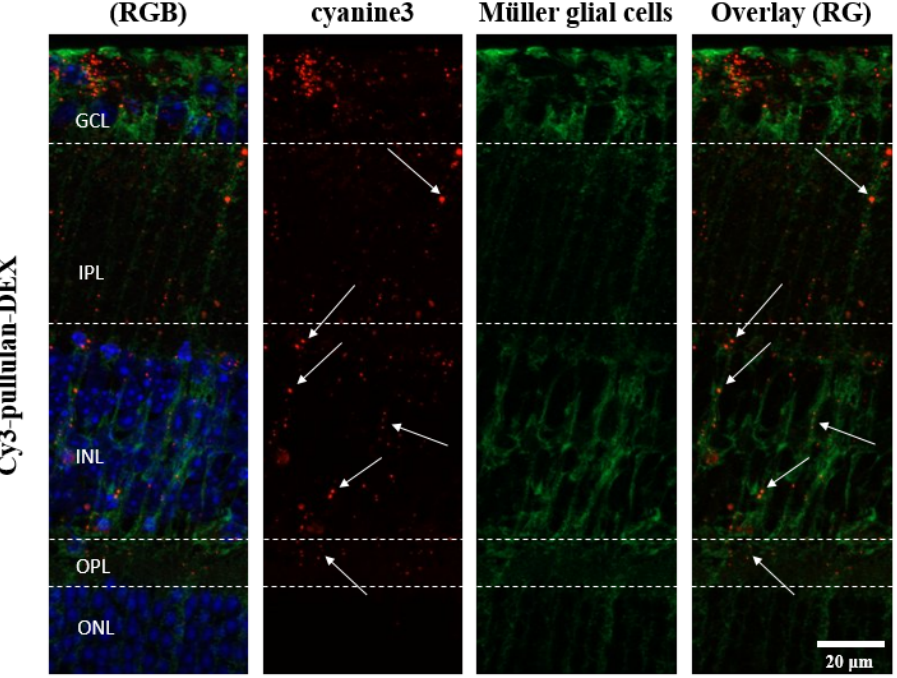
Figure 14. Images of retinal sections from two-months old mice after intravitreal injection (1 μ L) of 5 mg/mL Cy3-pullulan-DEX (cyanine3, red). Müller glial cells were labelled with an antibody against glutamine synthetase (green). Nuclei were stained with DAPI (blue). RG: overlay of red and green channels for Müller glial cell and nanoparticle colocalization. RGB: overlay of red, green and blue channels. Bar size: 20 μ m.